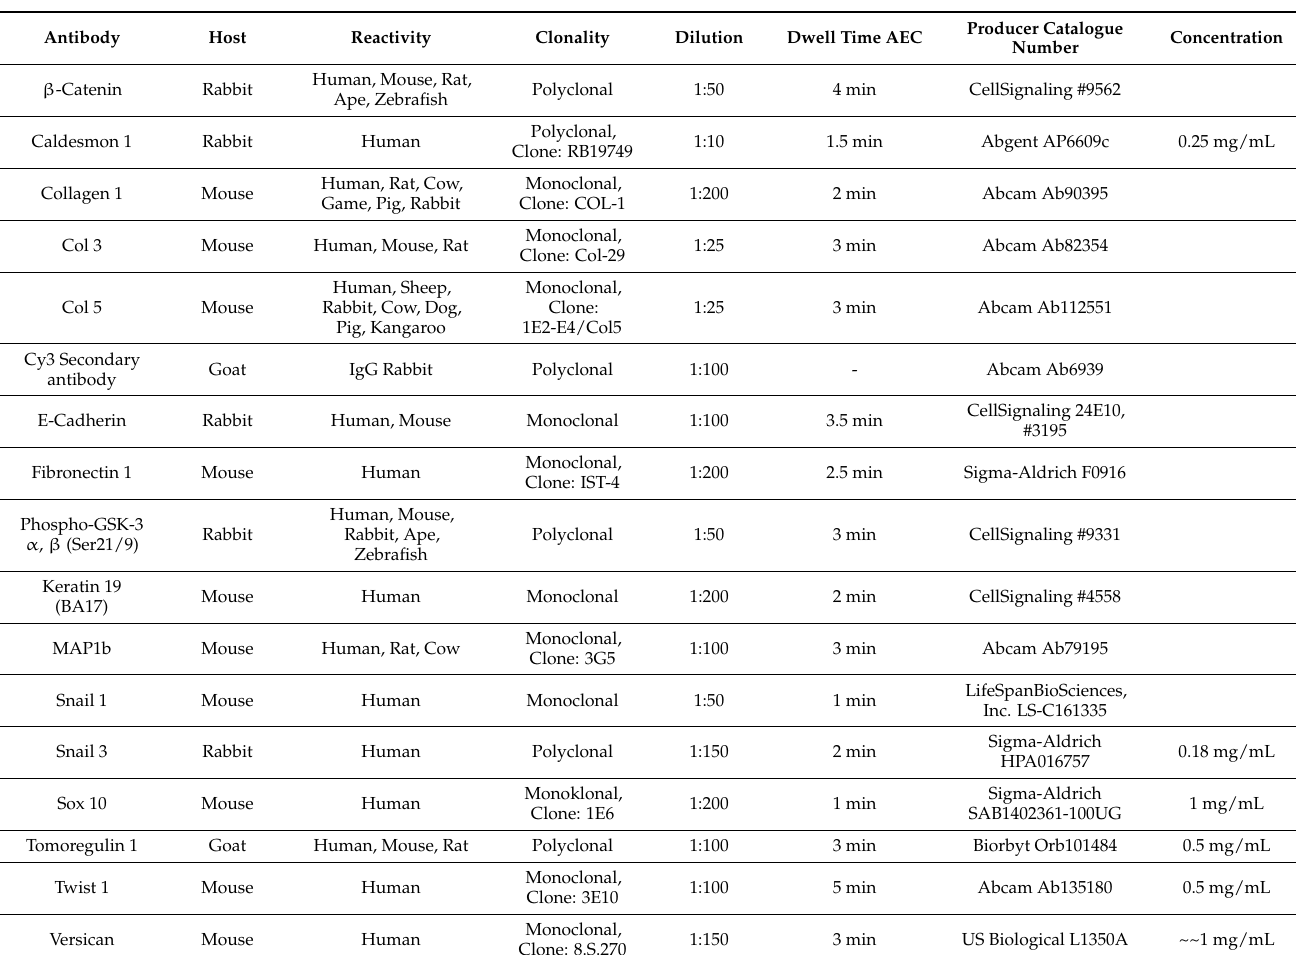
Table 1. Used antibodies.